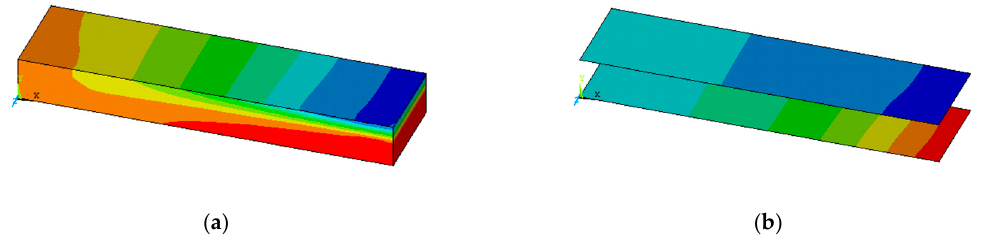
Figure 16. Principal strain map for specimen 2M2: ( a ) masonry, ( b ) TRM.